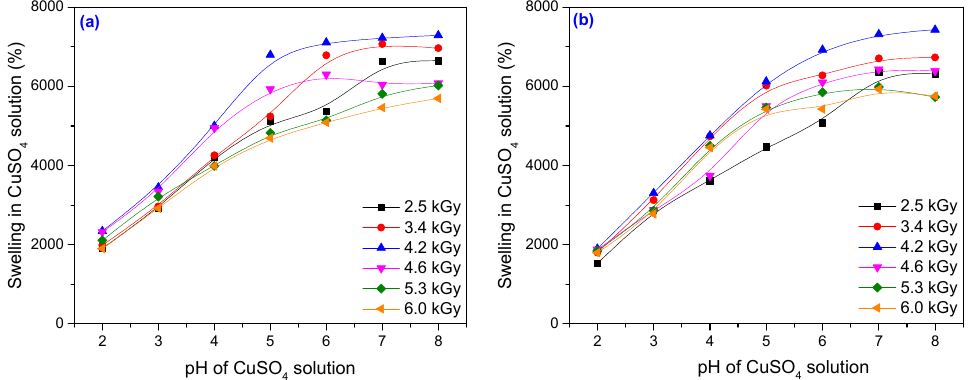
Figure 12. Swelling of the hydrogels in CuSO 4 solution as a function of pH, PP and TMPT amount: ( a ) 3.70 × 10 − 3 mol/L PP and 2.95 × 10 − 3 mol/L TMPT; ( b ) 7.40 × 10 − 3 mol/L PP and 5.90 × 10 − 3 mol/L TMPT.